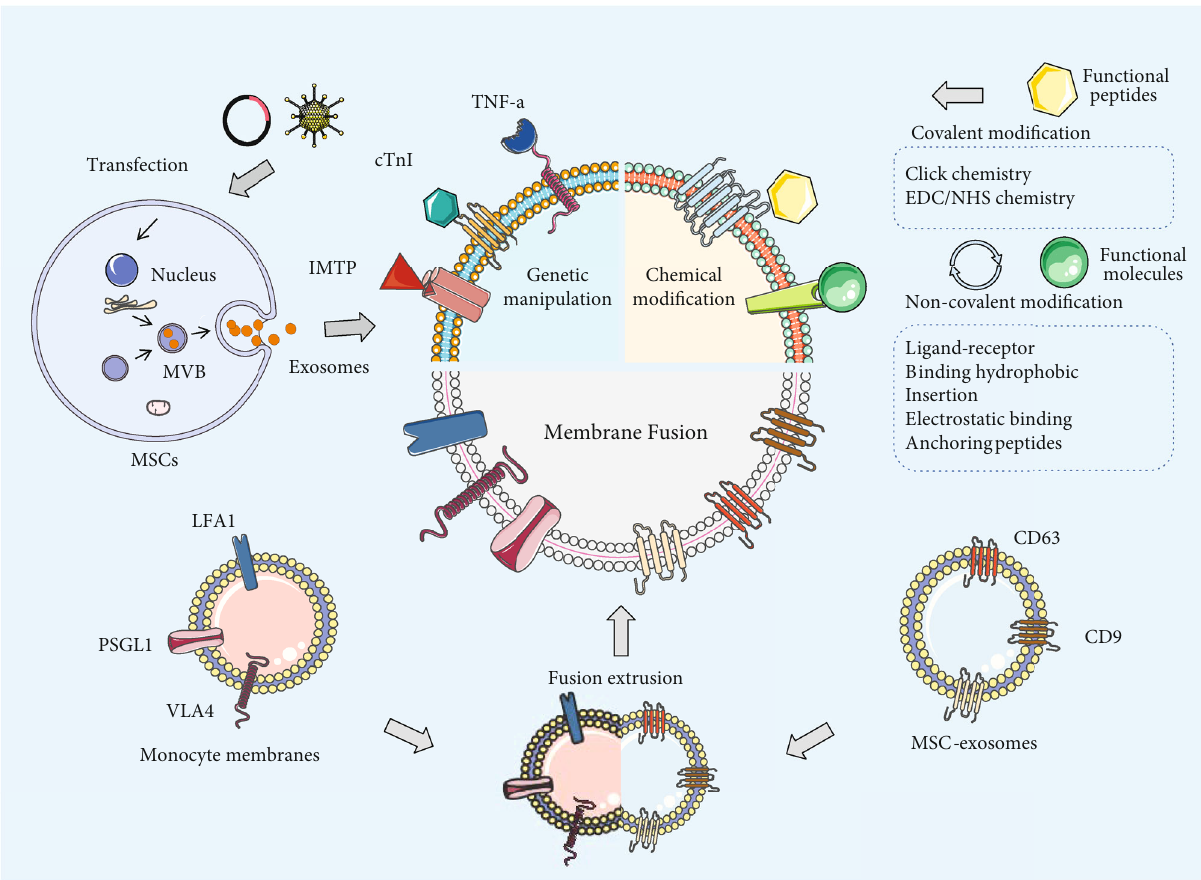
Figure 4: Three common strategies for membrane surface modi fi cation of MSC-exosomes include genetic engineering, chemical modi fi cation, and membrane fusion. Genetic engineering fuses gene sequences of guidance proteins or peptides with those of selected exosomal membrane proteins and can e ff ectively display speci fi c guidance peptides and proteins on the exosomal surface. In contrast, chemical modi fi cations display a variety of natural and synthetic ligands or receptors on the membrane surface through covalent or noncovalent modi fi cations. Membrane fusion uses extrusion to fuse exosomes with other membrane structures, an approach that confers new functional and therapeutic bene fi ts to